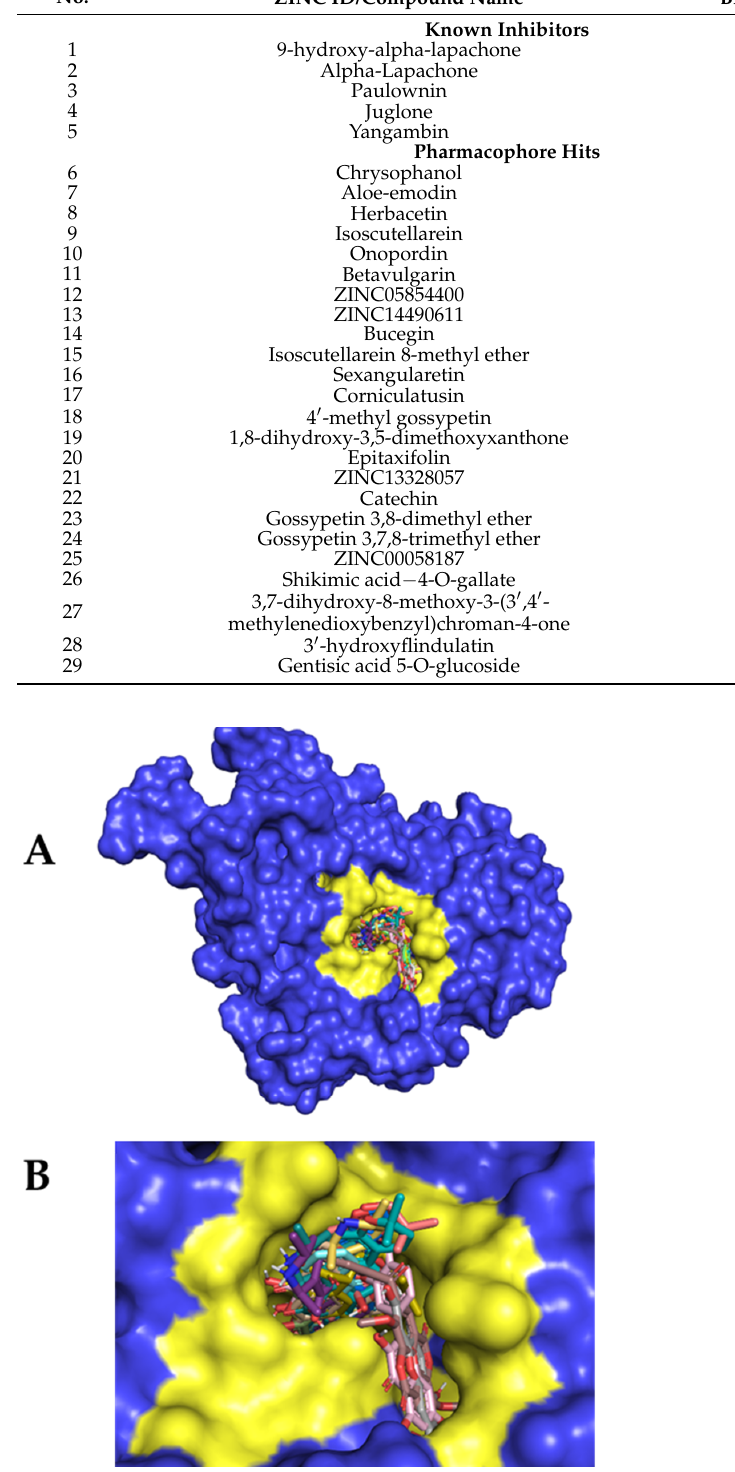
Figure 8. ( A ) Surface representation of ligand–target complex showing the docking results of best 24 hit ligands in the active site region colored cyan. ( B ) Magnified view showing ligands docked firmly in the pocket.